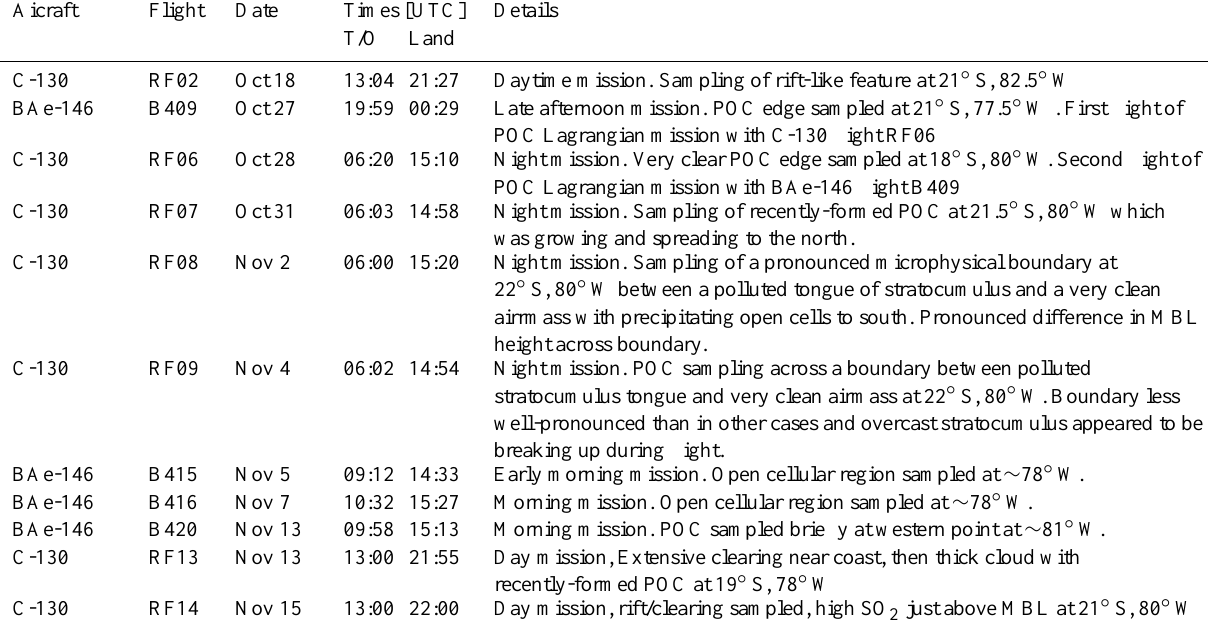
Table 11. Details of POC sampling/missions conducted in the VOCALS Regional Experiment. Aicraft